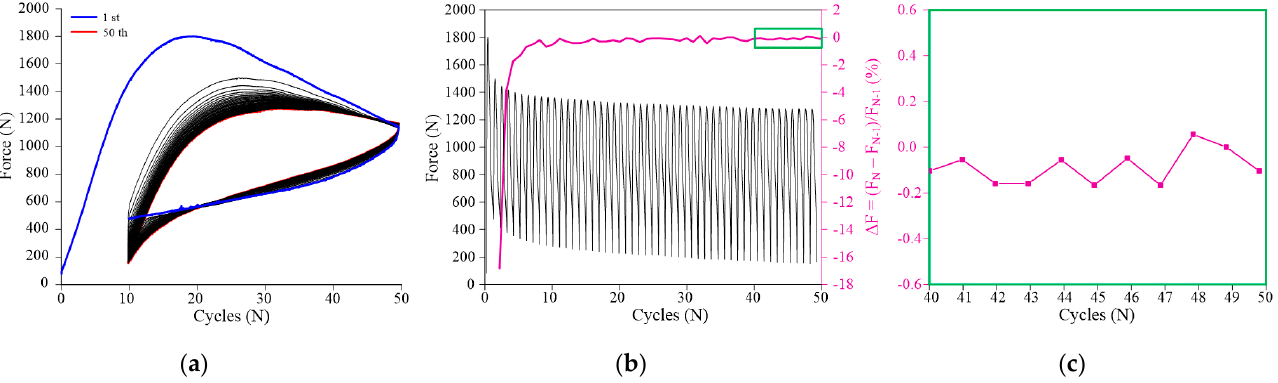
Figure 6. Mechanical behavior during the pre-cycling (at 0.1 Hz) of the superelastic behavior. ( a ) Force vs. deflection response. ( b ) Force vs. cycles response (left axis) and percentage force variation in relation to the N-1 cycle (right axis). ( c ) Detail of the percentage force variation.